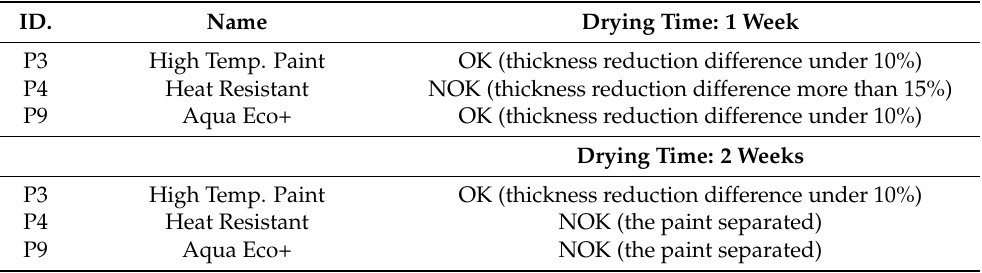
Table 14. Certification results of usability tests (materials: Al1–Al5, surface preparations: SC1, SC4, and